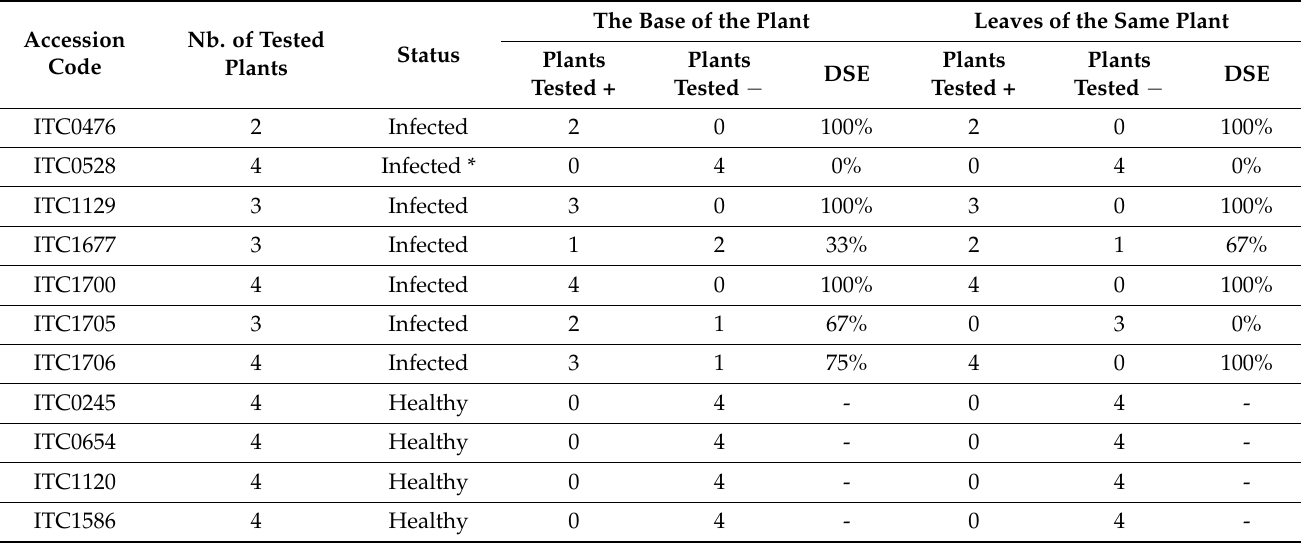
Table 3. Testing of BanMMV infection from either basal section or leaves of infected in vitro plants. DSE = diagnostic sensitivity. Tested + and – mean BanMMV detected or not detected